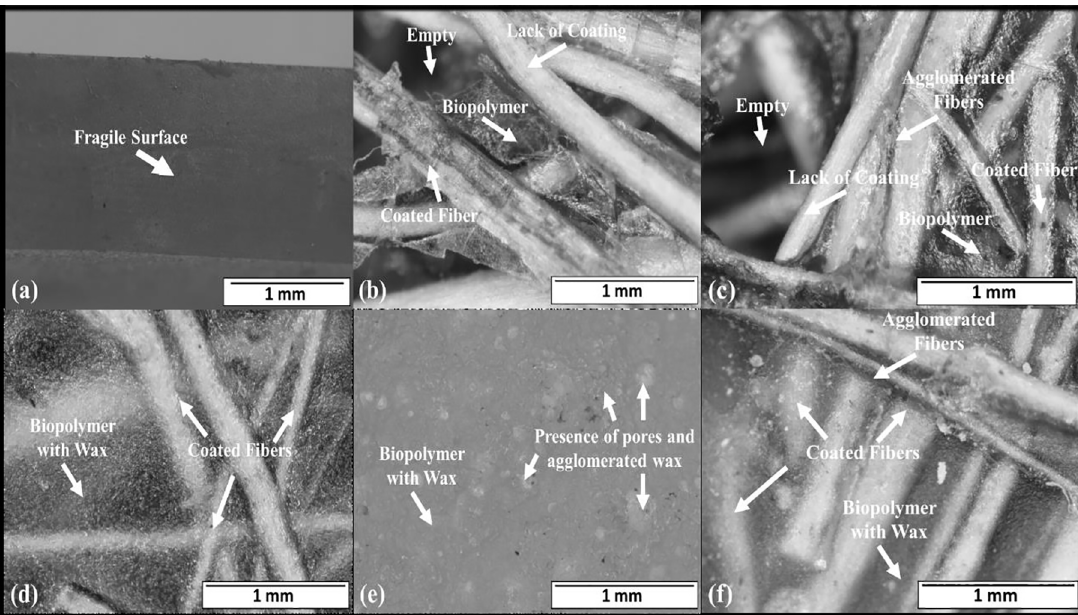
Figure 2. Optical microscopy of (a) Matrix of corn starch; (b) Biocomposite with 10% coconut fiber and (c) 20% coconut fiber; (d) Biocomposite with 10% coconut fiber and 10% carnauba wax; (e) Biocomposite with 20% carnauba wax; (f) Biocomposite with 20% coconut fiber and 20% carnauba